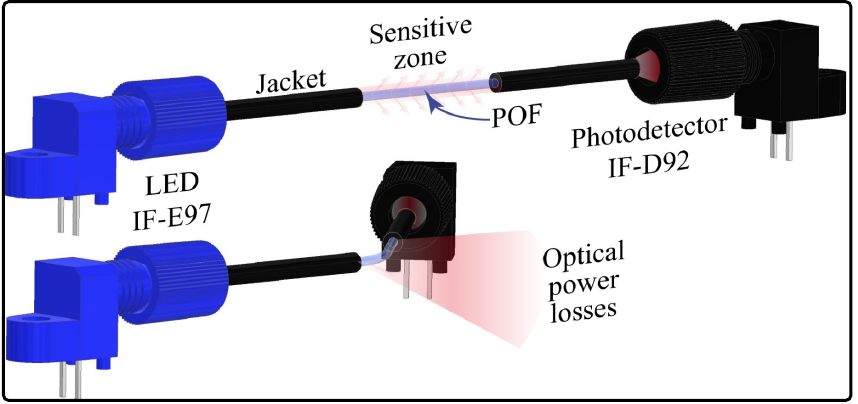
Figure 2. Working principle: jacket remotion with cladding and core axial polish angle sensor.